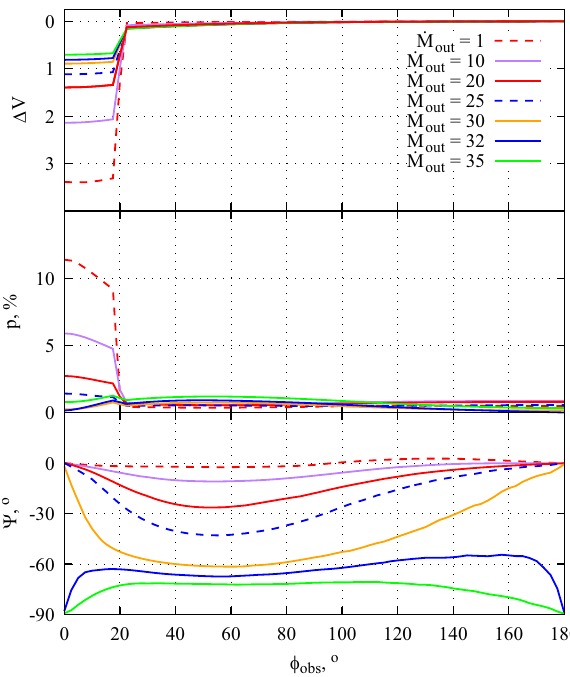
Figure 7: Change in magnitude ( top panel ) , polarization degree ( medium panel ) , and polarization position angle ( lower panel ) in the V band versus longitude of the observer ( ϕ